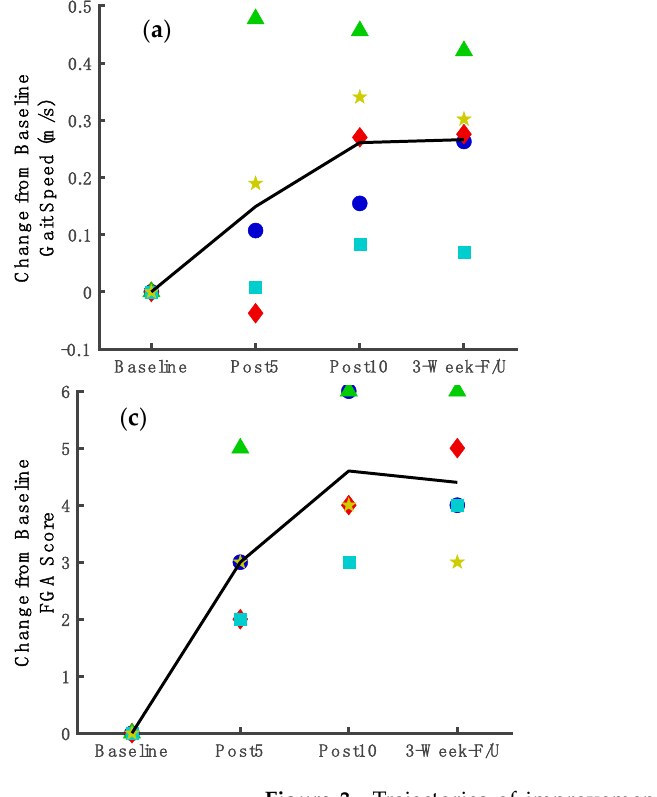
Figure 3. Trajectories of improvement in functional mobility and motor impairment measures throughout the study duration.